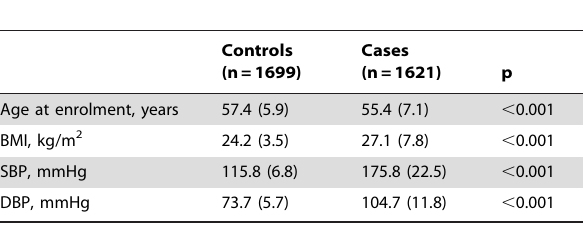
Table 1. Demographic characteristics of the discovery case control